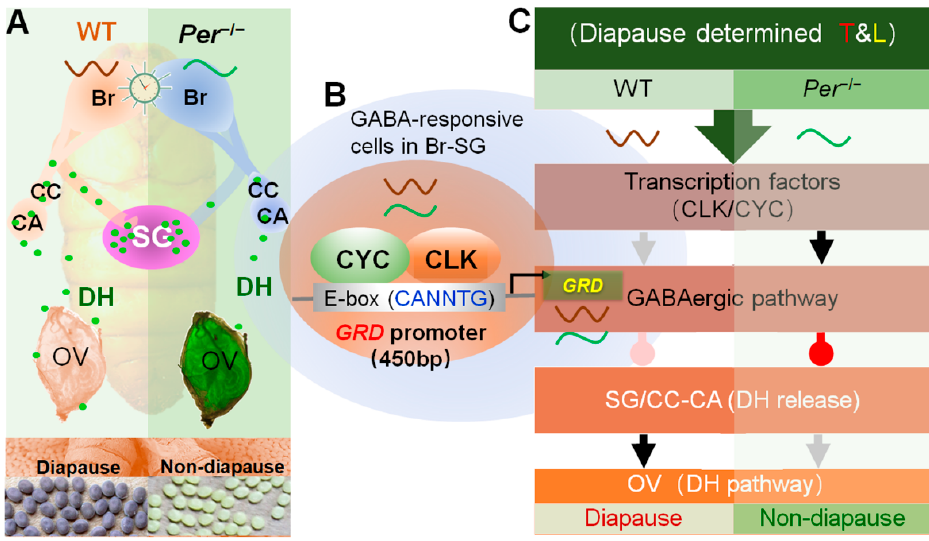
Figure 6. Summary about the diapause-destined mechanism changes in a circadian clock gene Period knockout mutant silkworm. Annotation: Per − / − , a Per -knockout strain of silkworm; Br-SG, brain-subesophageal ganglion complex; CC, corpus cardiacum; CA, corpus allatum; OV, ovary; T&L, temperature and light. ( A ) Knockout of Per changed the DH release in pupal stage. The pupal brain of Per − / − weakened the regulation effect on DH secretion, resulted in the decrease of DH level in the hemolymph and delay of the titer peak, and finally resulted in non-diapause eggs laid by the female moths. ( B ) The GABAergic pathway is transcriptional regulated by a circadian clock transcription factor. The CLK/CYC, a complex of TTFL transcription factor of the silkworm, combined with the promoter region of the GABA receptor GRD , directly regulated the gene transcription level. ( C ) The circadian clock regulates the secretion and action of DH through the GABAergic pathway. In the pupal Br-SG, the CLK/CYC directly regulated the transcription of GRD , affected the GABAergic pathway, and finally inhibited (delayed) the release of DH to hemolymph, and reduced the diapause-inducing effects of DH. The gray and black arrows indicate weak and strong excitatory signal, and the pink and red water drop symbols indicate weak and strong inhibitory signal, respectively.